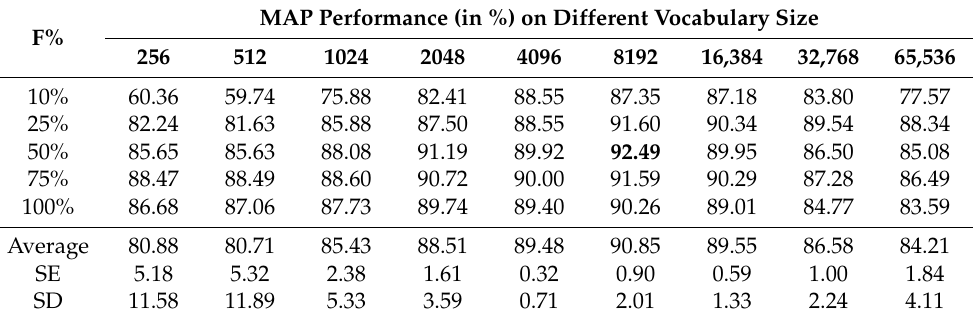
Figure 12. HKFV using 75% BFS vs. FAST and SURF keypoints detector on the Corel-1000 dataset. Table 4. The KFFVW Performance with various vocabulary sizes and BFS on the Corel-1000